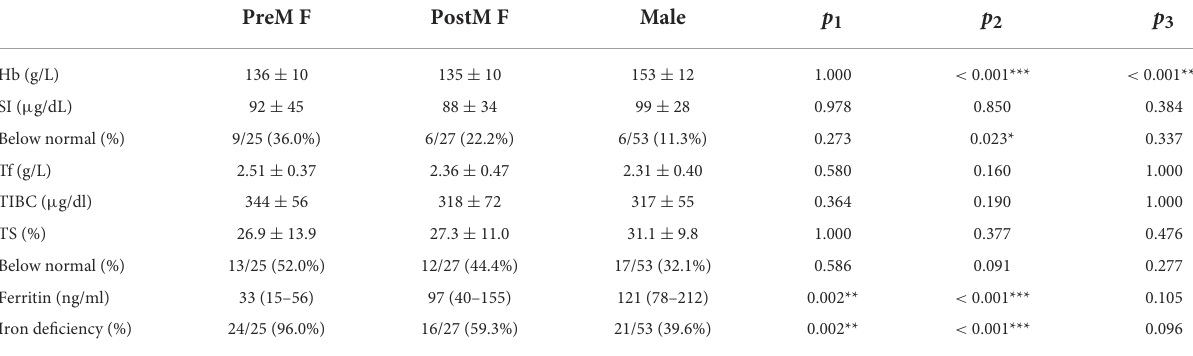
TABLE 2 Comparison of iron metabolism parameters among premenopausal female, postmenopausal female, and male patients with MG.